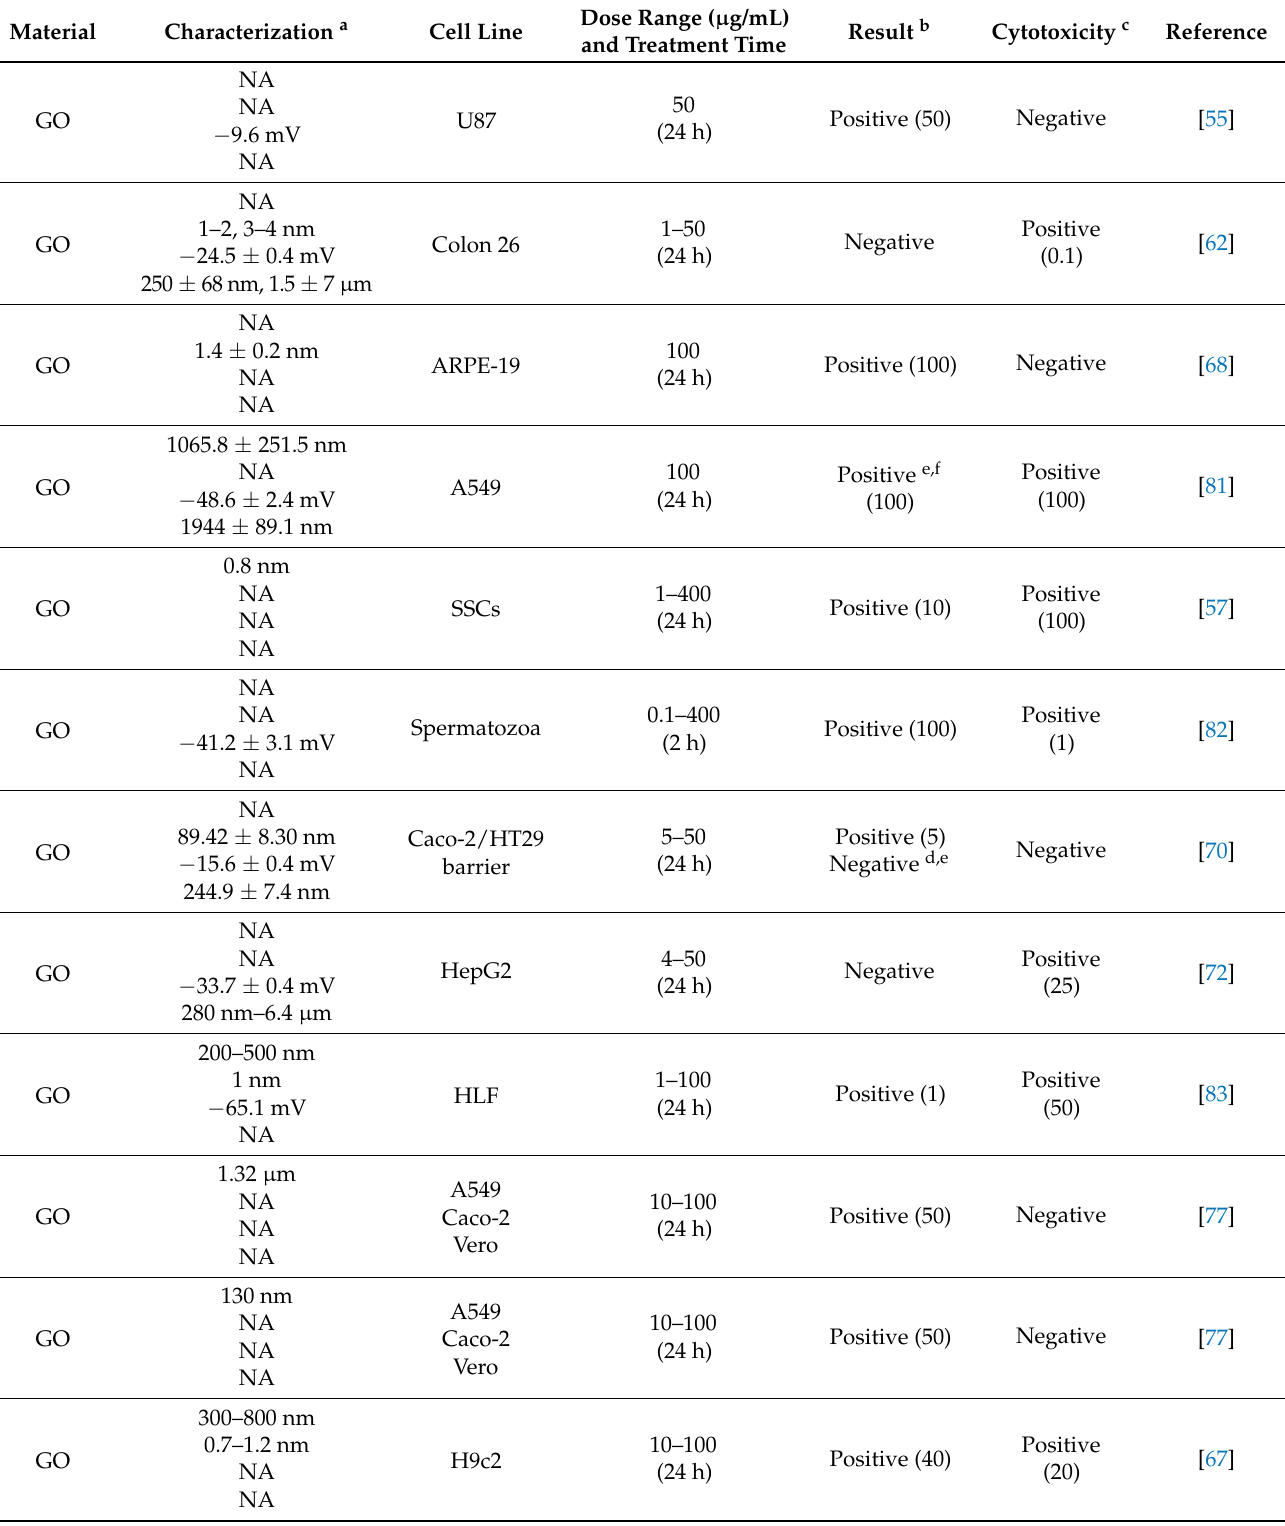
Table 4. In vitro studies assessing the genotoxicity of graphene oxide (GO) and GO-related materials using the comet